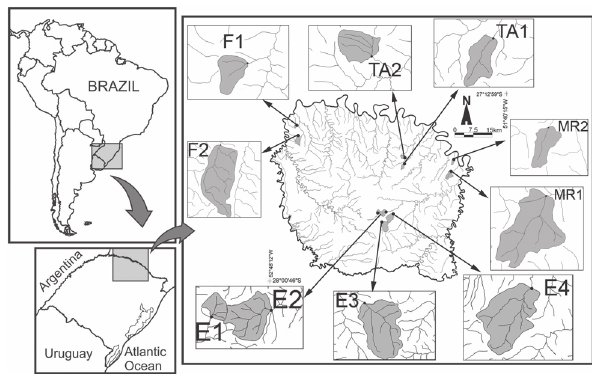
Figure 1. Geographical location of sampling sites at Alto Uruguay region, RS. F: Faxinalzinho, TA: Três Arroios, ERE: Erechim, MR: Marcelino